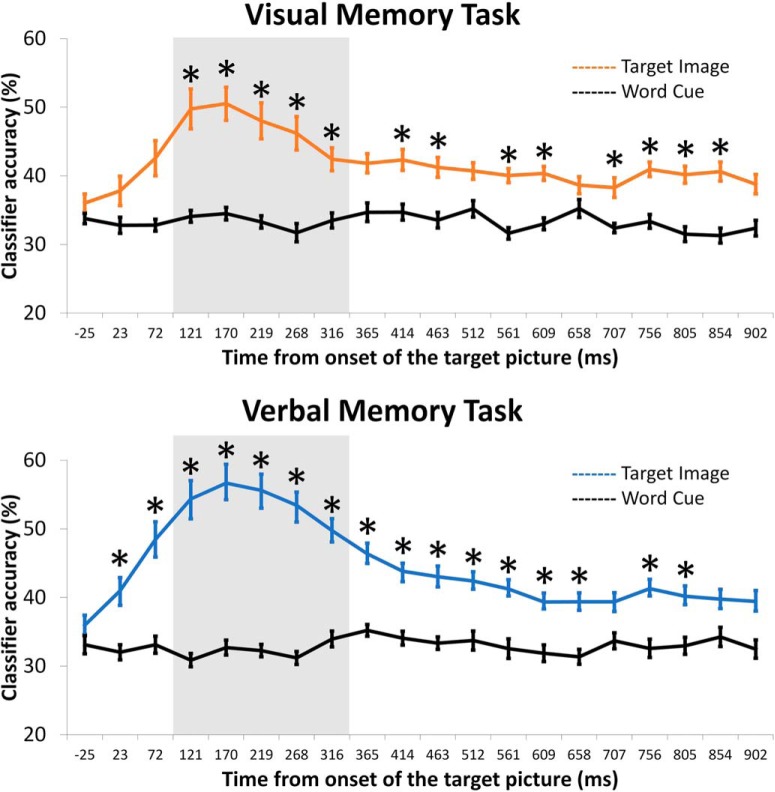
Averaged accuracy of the 20 cross-validated pattern classifiers trained to discriminate between faces, landmarks, and objects during the encoding phase of the visual and of the verbal memory task. The colored line represents the accuracy of the classifiers trained during the presentation of the target picture. The black line shows the baseline accuracy of the classifiers trained during word cue presentation. Highlighted (*) are the times bins for which classification performance survived multiple comparison correction. In gray is highlighted the time bins for which classification accuracy was highest.